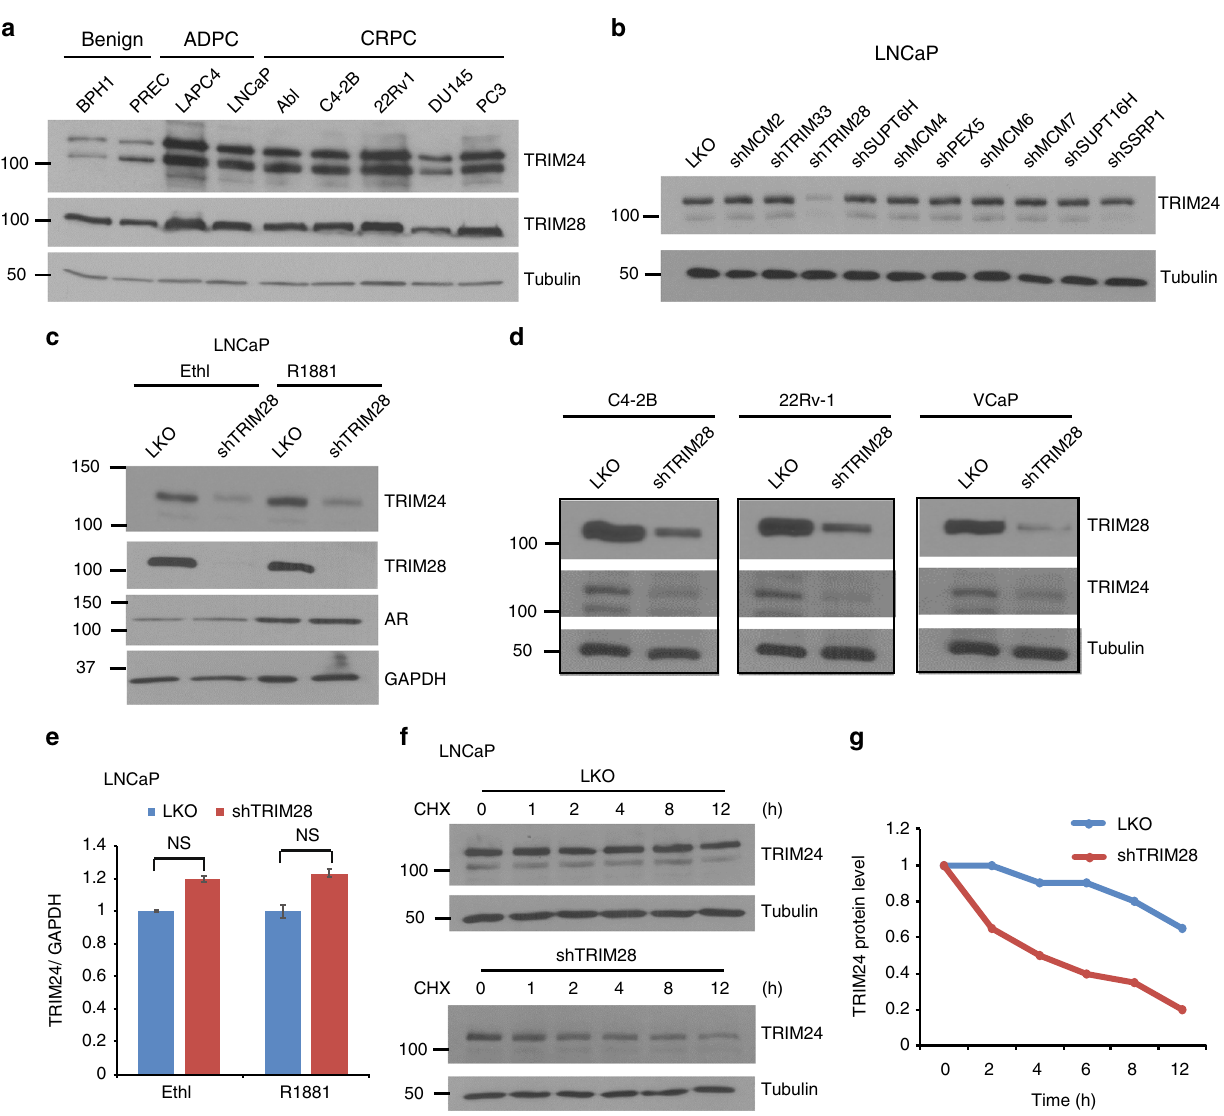
Fig. 1 TRIM28 is a positive regulator of TRIM24 protein stability. a Equal amount of protein lysates from a panel of prostate cells were loaded for SDS- PAGE and western blot analysis was carried out to detect expression of TRIM24 and TRIM28. Tubulin was used as loading control. b TRIM28, but not other interactors, positively regulate TRIM24 protein level. Lentiviral supernatant containing pLKO control or shRNAs against top 10 TRIM24-interactors were used to infect LNCaP cells. Four days after infection, protein lysates were harvested and immunoblot performed to examine the expression of TRIM24. GAPDH was used as a loading control. c TRIM28 positively regulates TRIM24 protein. LNCaP cells expressing control (pLKO) or shTRIM28 were hormone-starved for 3 days and treated with either ethanol or 1 nM R1881 for 48 h. Protein lysates were harvested and subjected to immunoblotting analysis using indicated antibodies. d PCa cell lines expressing control (pLKO) or shTRIM28 were subjected to western blot analysis. Tubulin was used as a loading control. e TRIM24 transcript expression is not dependent on TRIM28. RNA was extracted from LNCaP cells expressing control (pLKO) or shTRIM28 and subjected to qRT-PCR analysis. Data shown is mean (± SEM, n = 3). NS: not signi fi cant. f , g TRIM28 prolongs the half-life of TRIM24 protein. LNCaP cells infected with shCtrl or shTRIM28 lentiviruses were treated with 100ug/ml Cyclohexamide and protein lysates were collected at the indicated times for western blot analysis ( f ). TRIM24 protein level was quanti fi ed and plotted relative to the 0 time point ( g